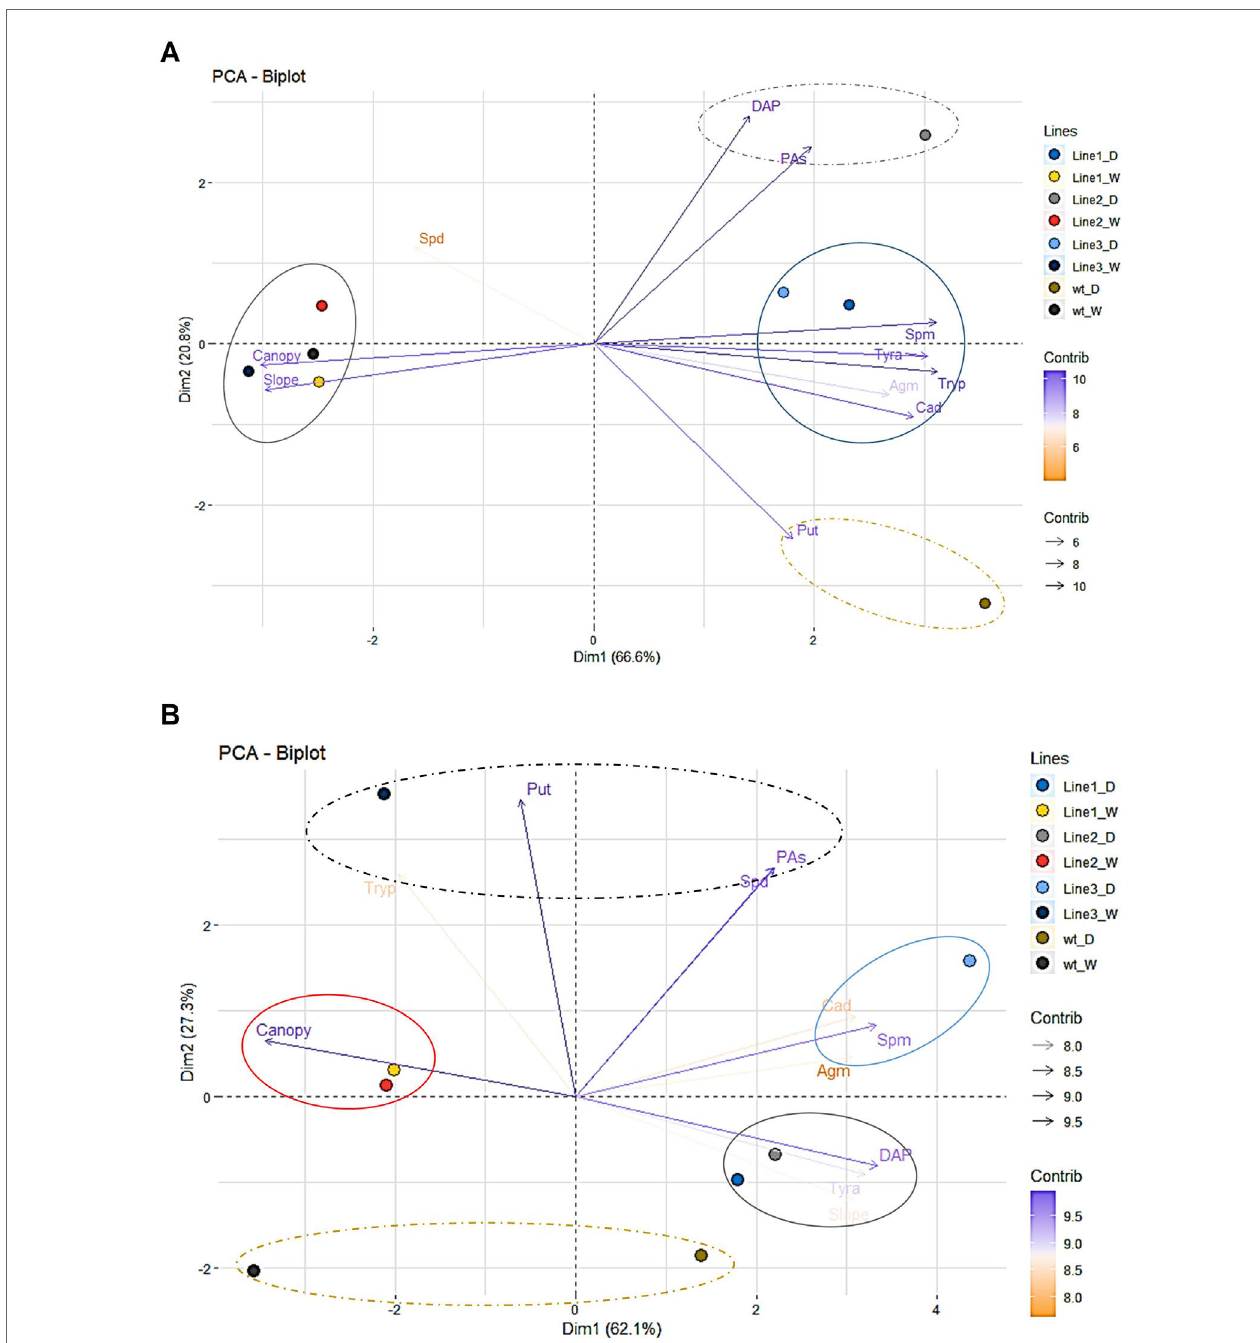
FIGURE 11 | Multivariate statistical analyses of the traits in barley seedlings from different transgenic lines related to the water stress response and subsequent rewatering. Principal component (PC = Dim) analysis at the end of the water stress period (A) and after subsequent rewatering (B)